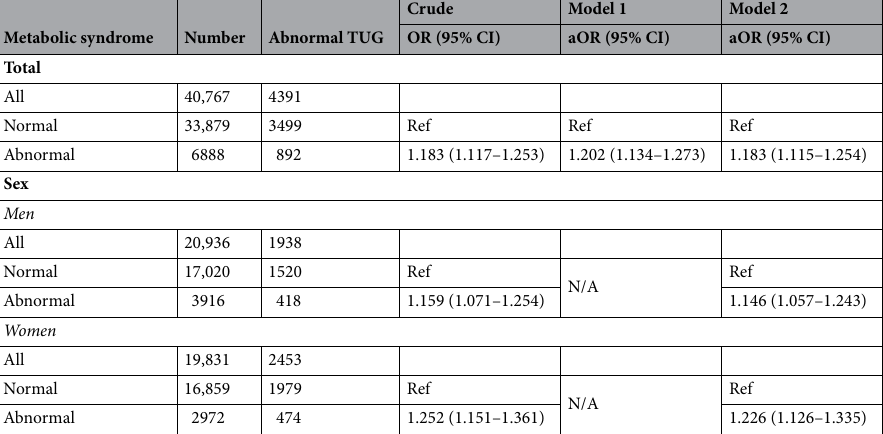
Table 2. Association between metabolic syndrome and timed up and go test. Model 1: sex. Model 2: Model 1 + depressive mood, cognitive impairment. TUG timed up and go, OR odds ratio, aOR adjusted odds ratio, CI confidence interval, N/A not